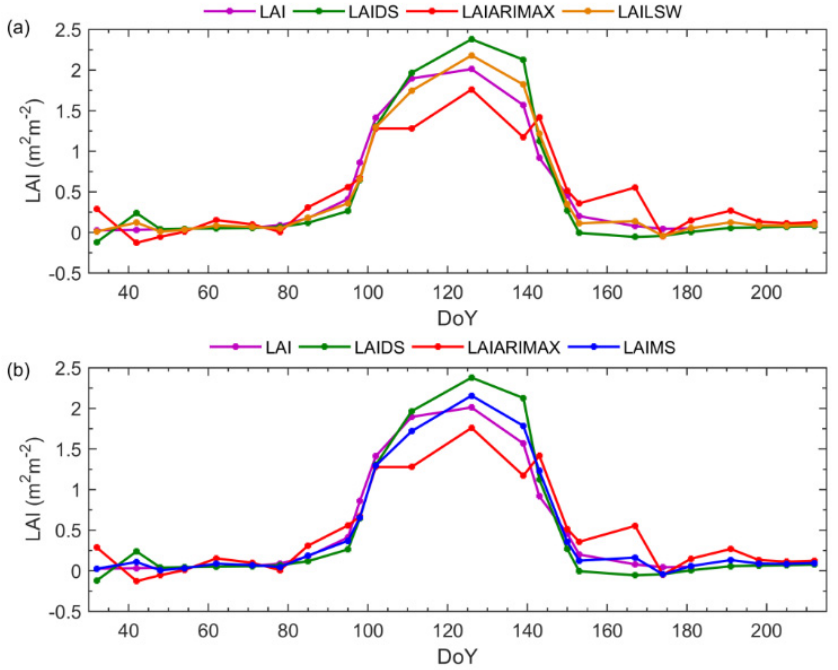
Figure 7. Combination prediction for LAI: ( a ) weighted least squares; ( b ) mean squared. LAI: interpolated data; LAIDS: double smoothing; LAIARIMAX: ARIMAX; LAILSW: weighted least squares; LAIMS: mean squared.